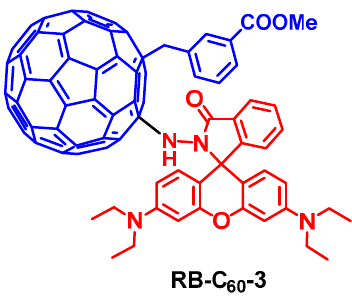
Figure 19. Rhodamine-C 60 dyad showing acid-activatable 1 O 2 production capability, used for the PDT study.